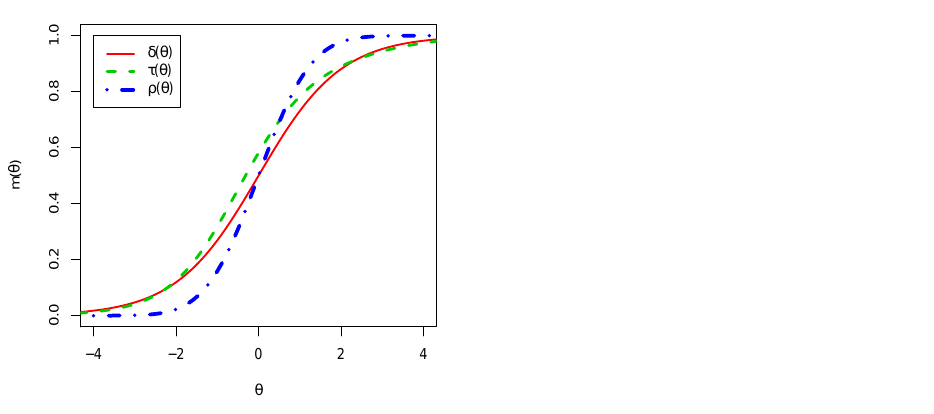
Figure 4. Transformation functions δ = δ ( θ ) , τ = τ ( θ ) and ρ = ρ ( θ ) of latent ability θ for the PISA 2006 reading test.